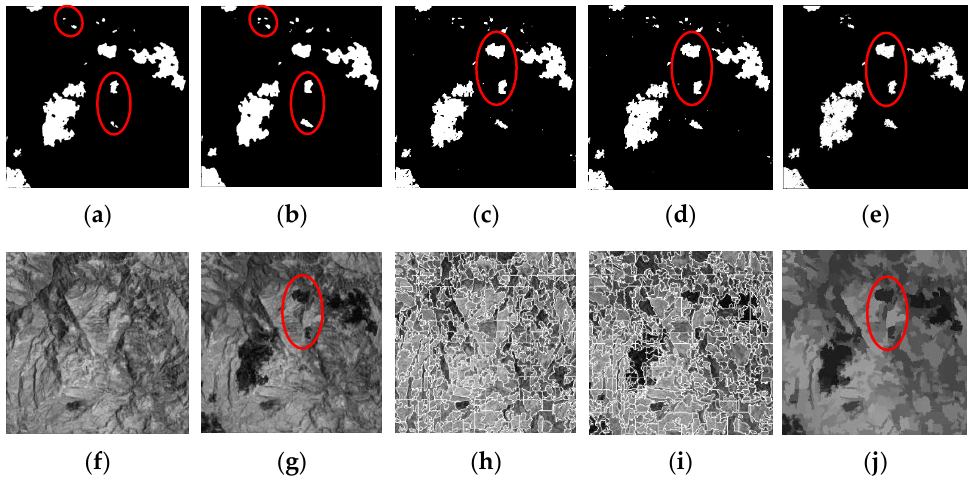
Figure 15. Change detection results and superpixel generation of transfer learning experiment for Mexico (optical) datasets. ( a ) FC-Siam-diff; ( b ) SSN-Siam-diff; ( c ) FC-Siam-conc; ( d ) SSN-Siam-conc; ( e ) ground truth; ( f ) 𝑡 1 image; ( g ) 𝑡 2 image; ( h , i ) superpixel generation via SSN-Siam-diff for 𝑡 1 and 𝑡 2 images. ( j ) The pixel value of the 𝑡 2 image is replaced by the mean value of the superpixel to which this pixel belongs. The areas marked by red circles deserve more attention.